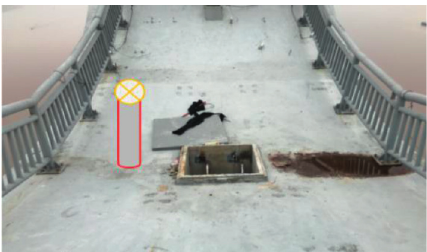
Figure 16: Photograph of the GNSS measuring point of the bridge